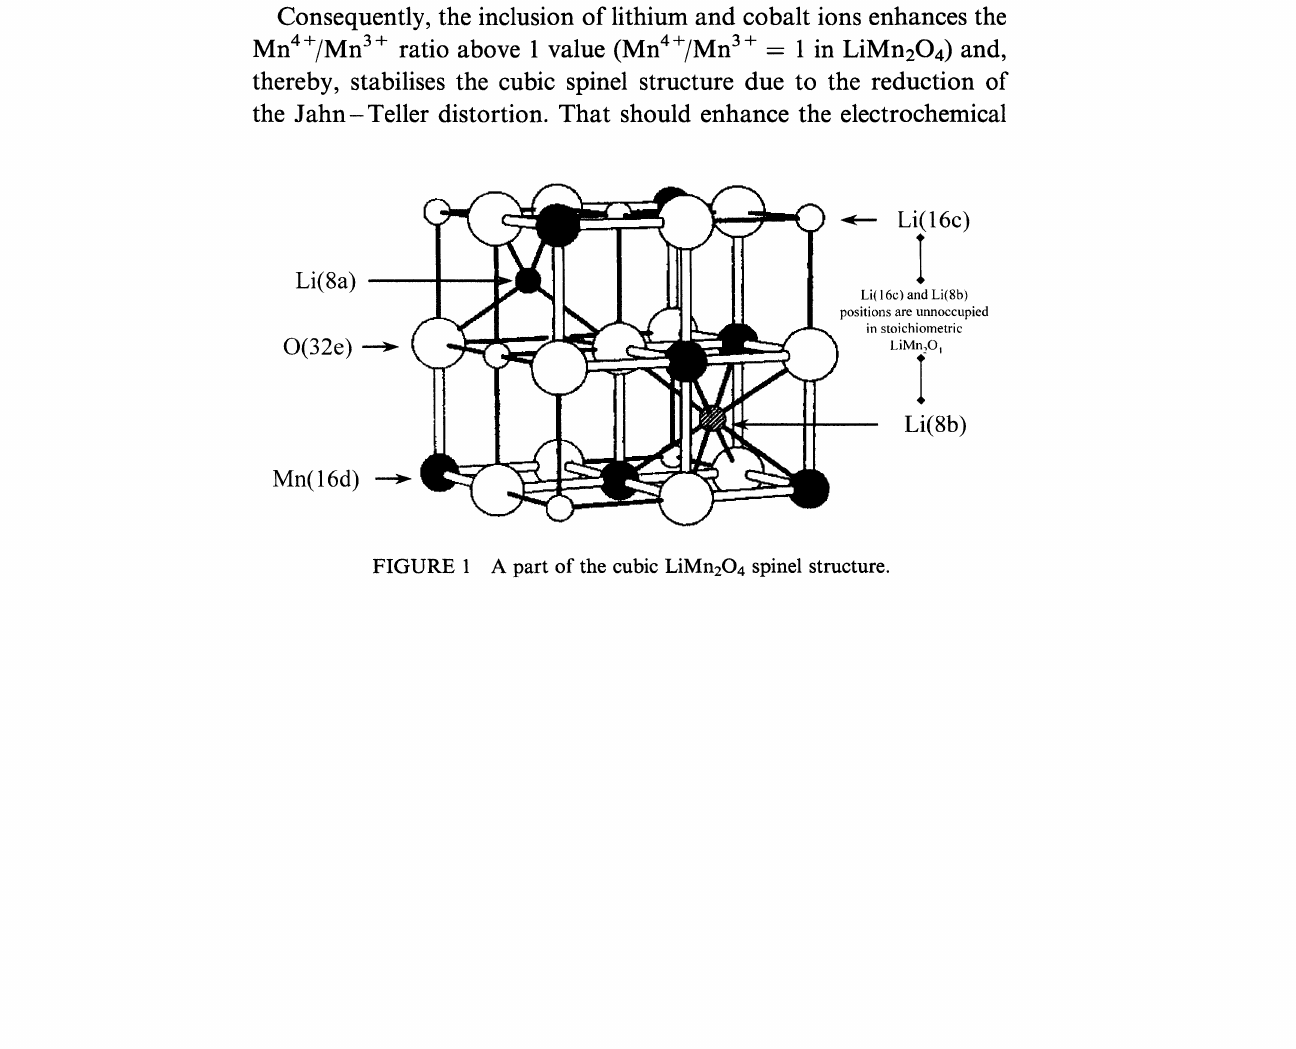
FIGURE A part of the cubic LiMn204 spinel